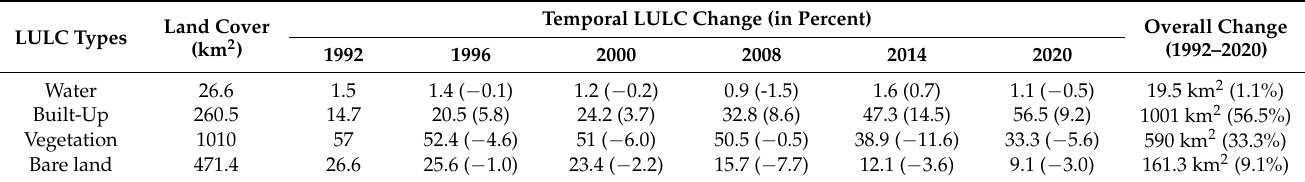
Table 2. Temporal LULC changes (in percent) for each measured year from the previous one from period 1992 to 2020 with overall